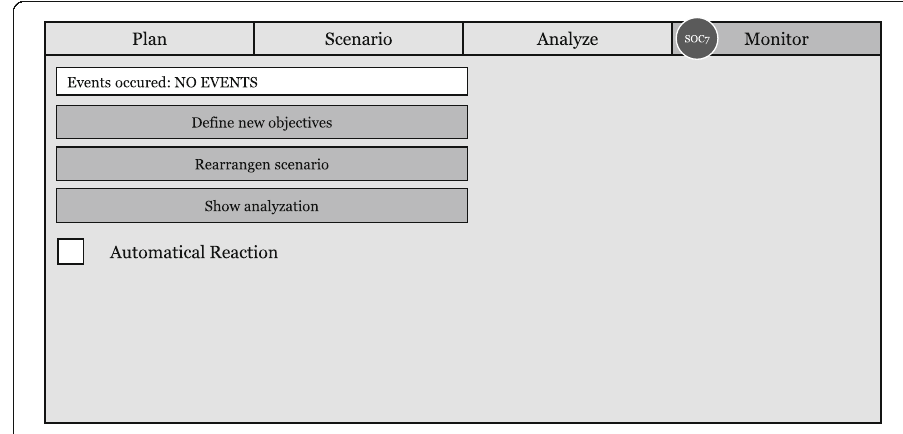
Fig. 10 Monitoring and event reaction (schematic